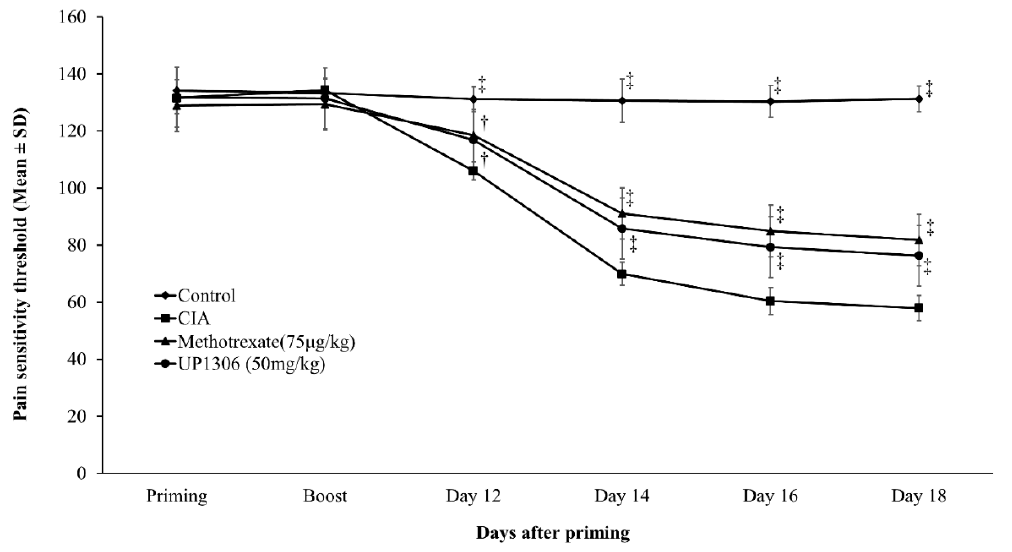
Figure 4. Pain tolerance of rats compared to vehicle treated CIA rats. Rats ( n = 10/group) were orally treated with UP1306 (50 mg/kg) and Methotrexate (75 µ g/kg) daily for three weeks post model induction. Data are mean ± SD. † p ≤ 0.0001 vs. vehicle treated CIA; ‡ p ≤ 0.00001 vs. vehicle treated